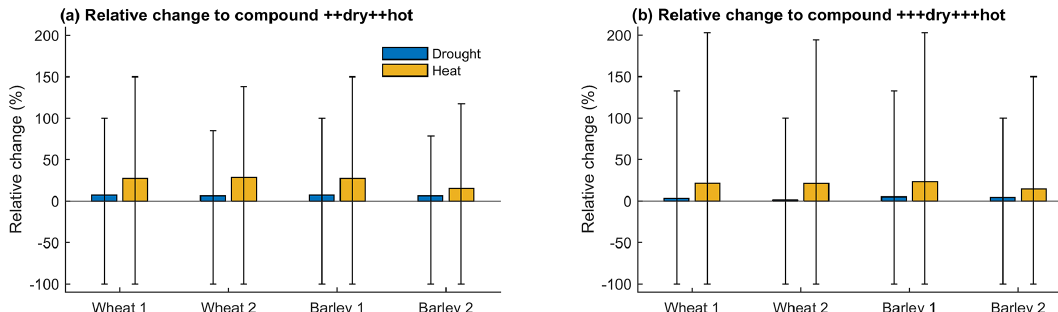
Figure A3. Same as Fig. 8 but for severe (a) and extreme (b)